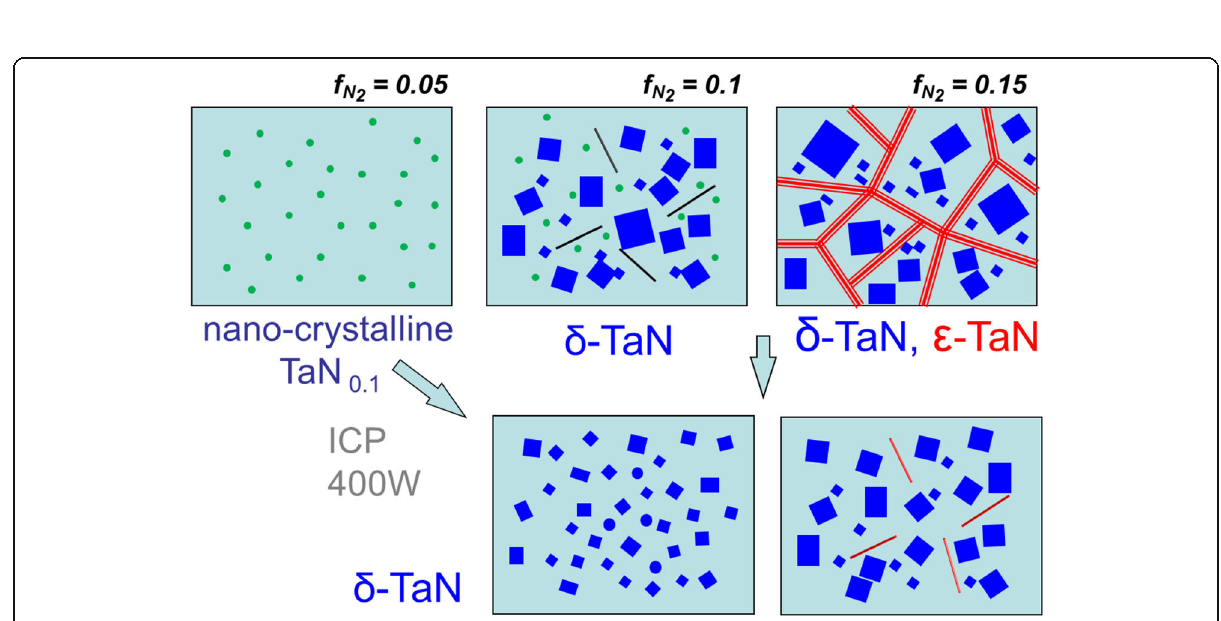
Fig. 7 Schematic representation illustrating microstructural evolution of TaN x films with the change of nitrogen gas fractions ( f N2 ) and ICP